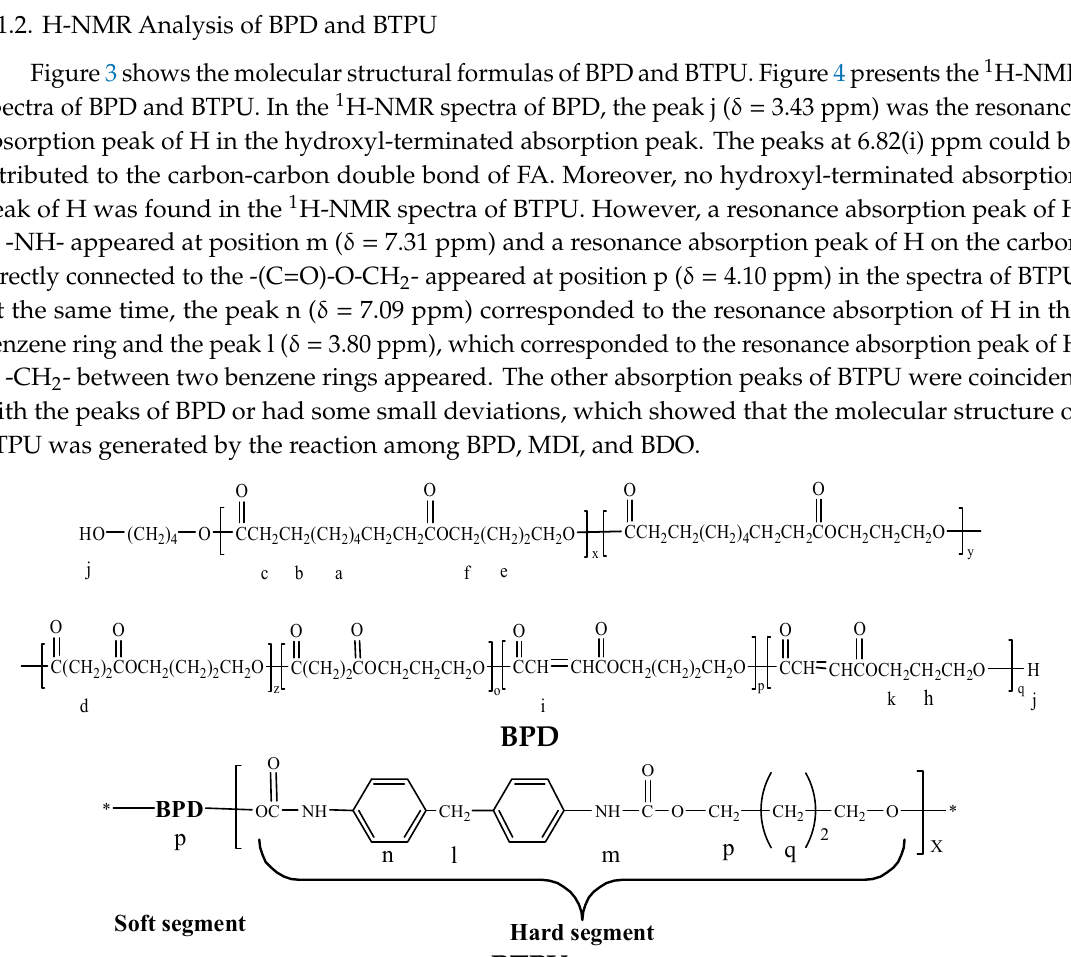
Figure 2. FTIR spectra of biodegradable polyester diols (BPD) and BTPU.